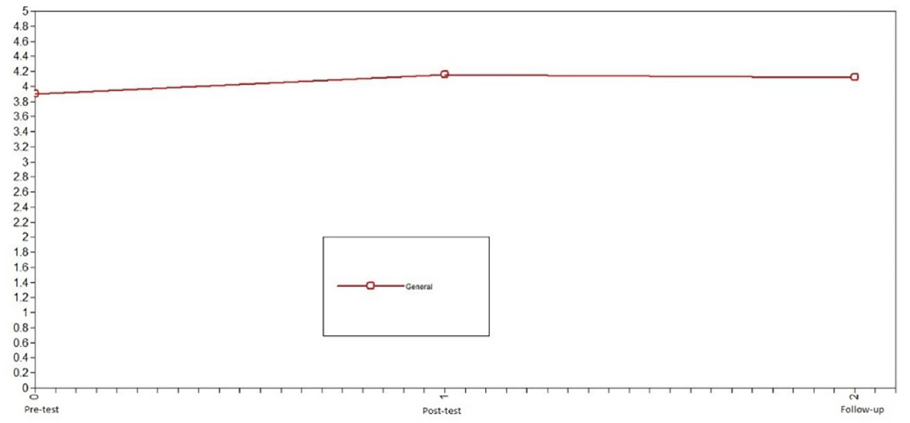
Fig 10. Latent growth curve models of prosocial behavior toward family of the intervention group. The model that presented the best fit was the nonlinear change model.